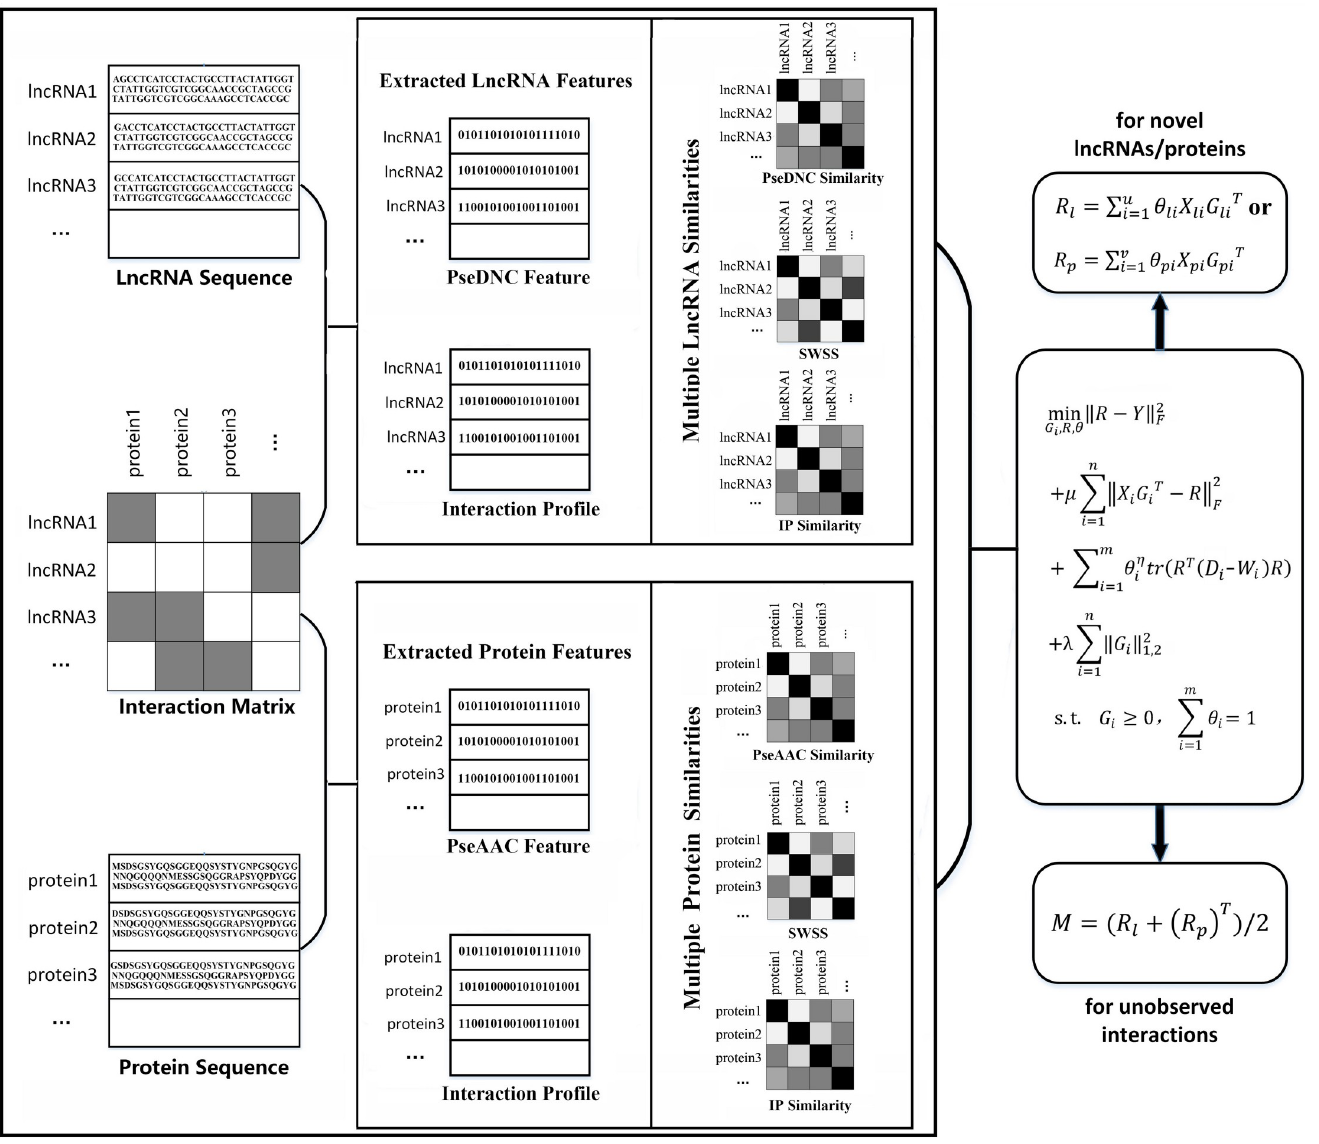
Fig 1. The flowchart of SFPEL-LPI for predicting lncRNA-protein interactions.